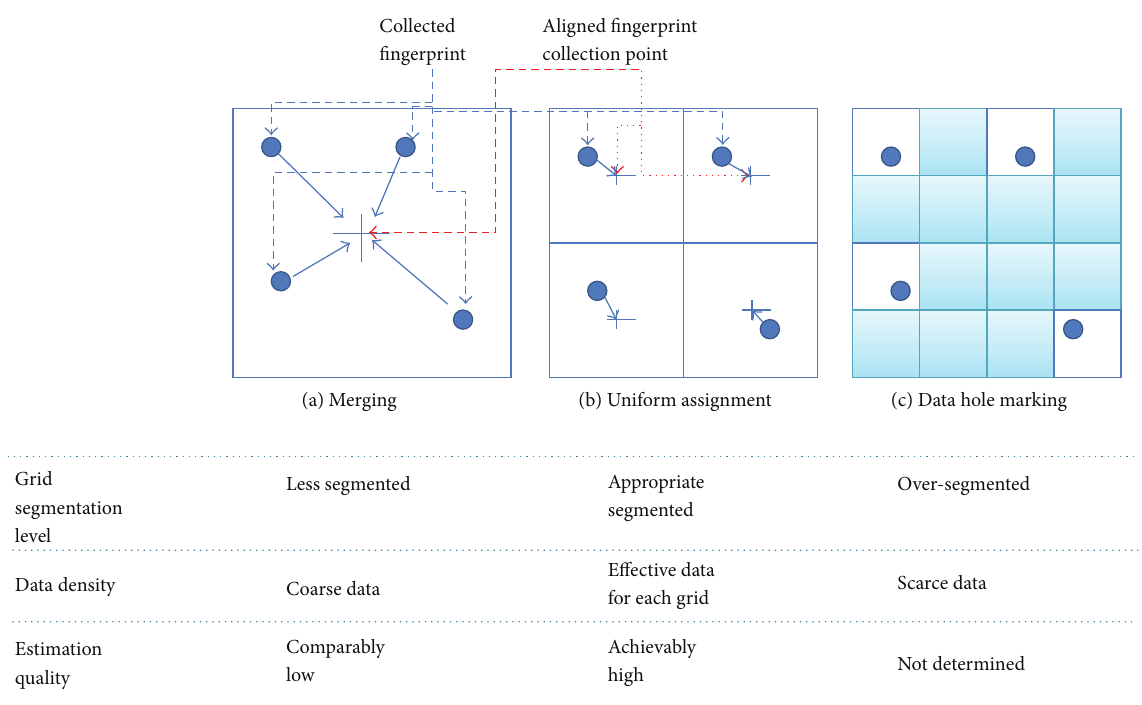
Figure 3: Grid segmentation level and fingerprint data